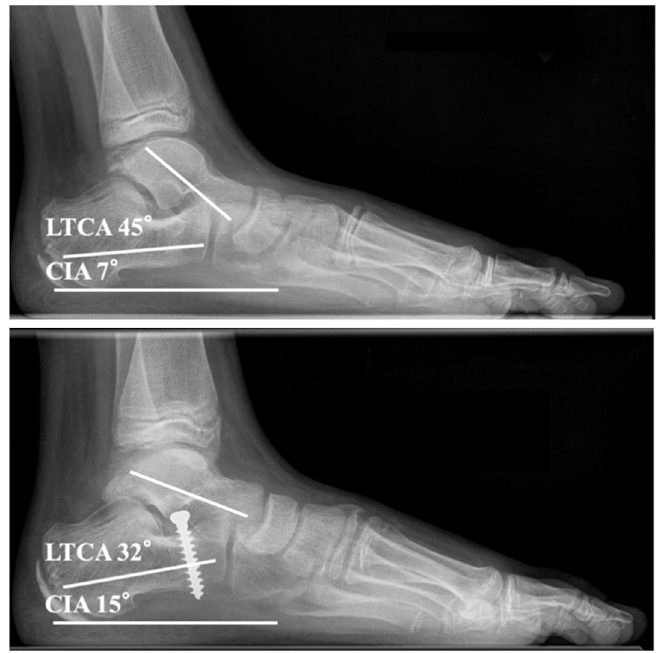
Figure 4. Full weight bearing lateral radiographs before and after subtalar extra-articular screw arthroereises: Improvement of the calcaneal inclination angle (CIA) and lateral talocalcaneal angle (LTCA) from 7° and 45° before surgery ( top ) to 15° and 32° after surgery ( bottom ), respectively (same patient as shown in Figures 2, 3 and 5).